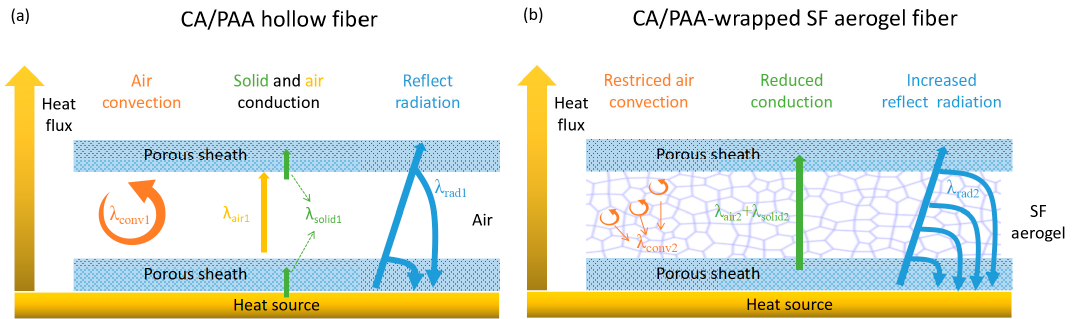
Figure 8. Schematic illustration of the thermal insulation behaviors of the ( a ) hollow and ( b ) aerogel